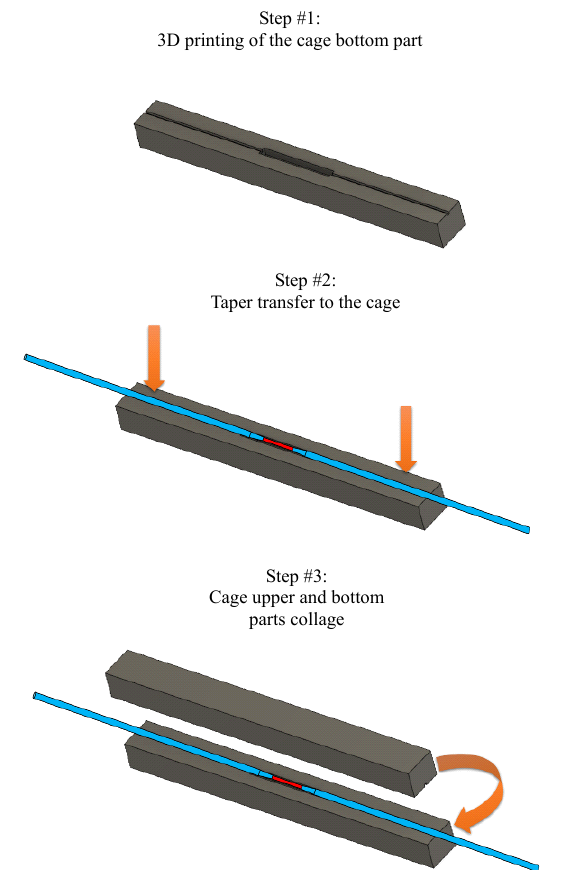
Fig. 1 Schematic diagram of the taper cage preparation